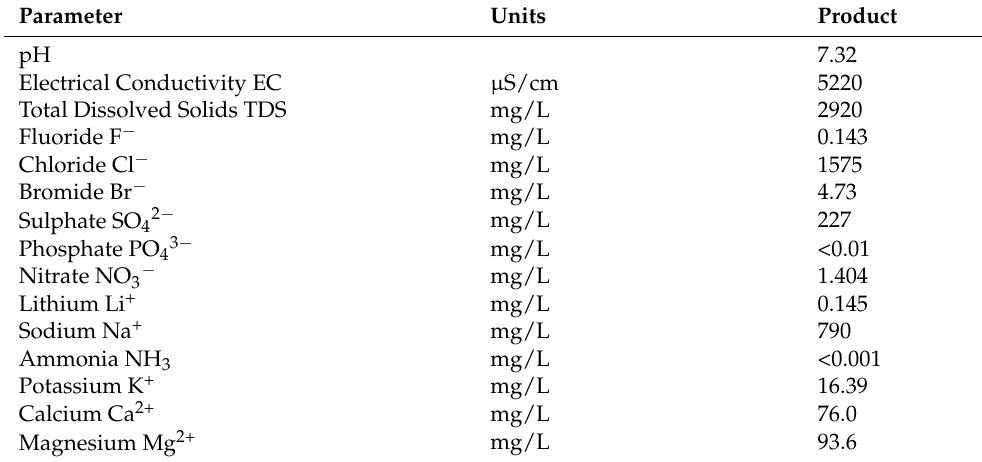
Table 3. Sample 2 (26 May 2022) Water Analysis (Prototype #1).